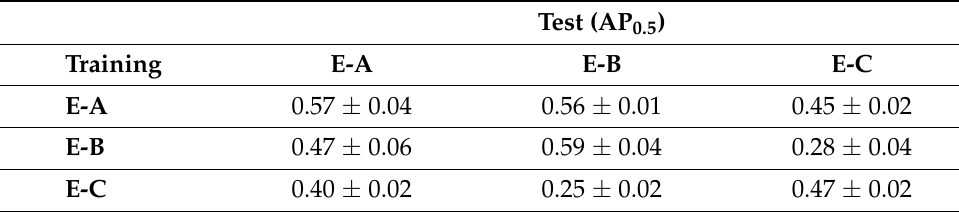
Table 5. Experimental results of YOLOv4.